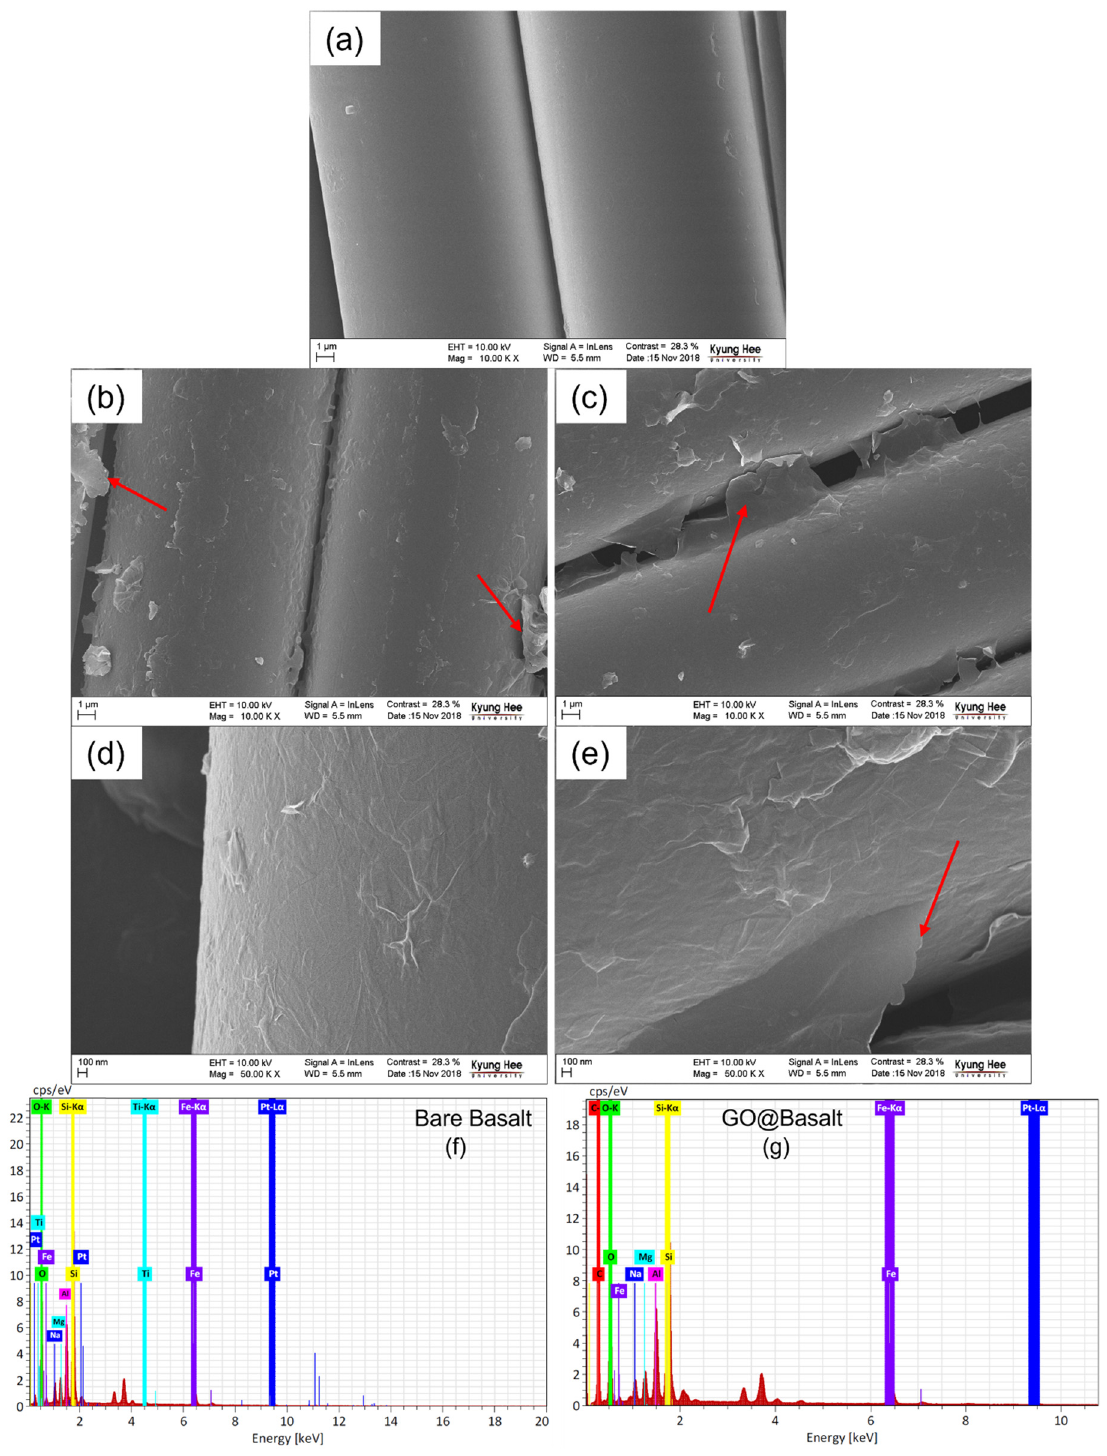
Figure 3: FE - SEM images of ( a ) uncoated basalt fi ber, ( b and c ) GO@Basalt and ( d and e ) rGO - coated basalt fi ber ( rGO@Basalt ) . EDS spectra of uncoated basalt fi ber ( f ) and GO@Basalt ( g )